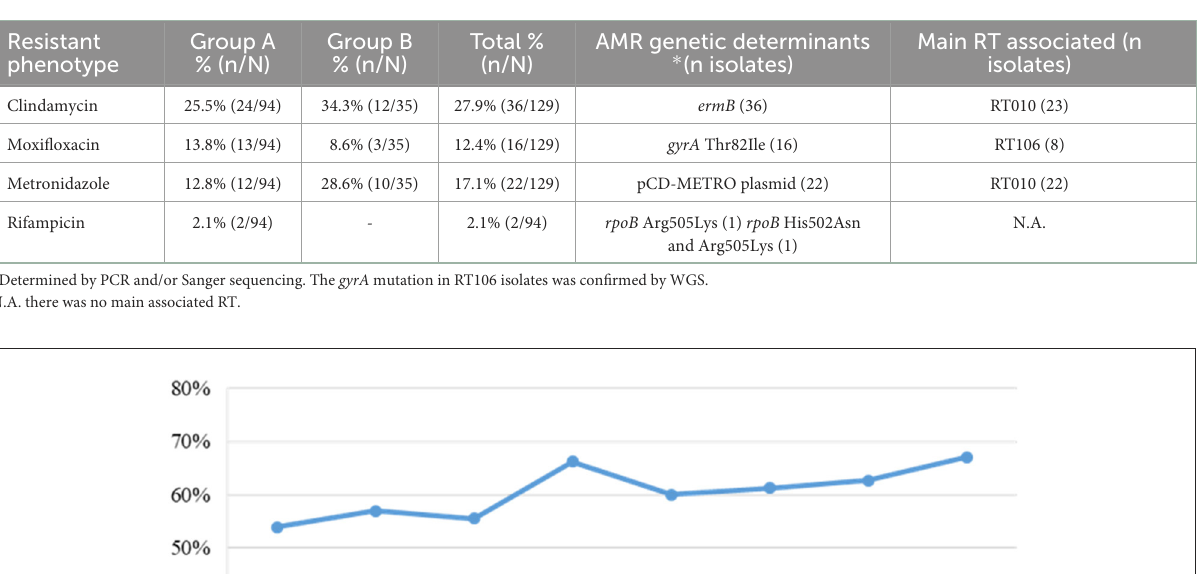
TABLE 2 Antimicrobial resistance prevalence and genetic determinants of resistance in groups A and B.